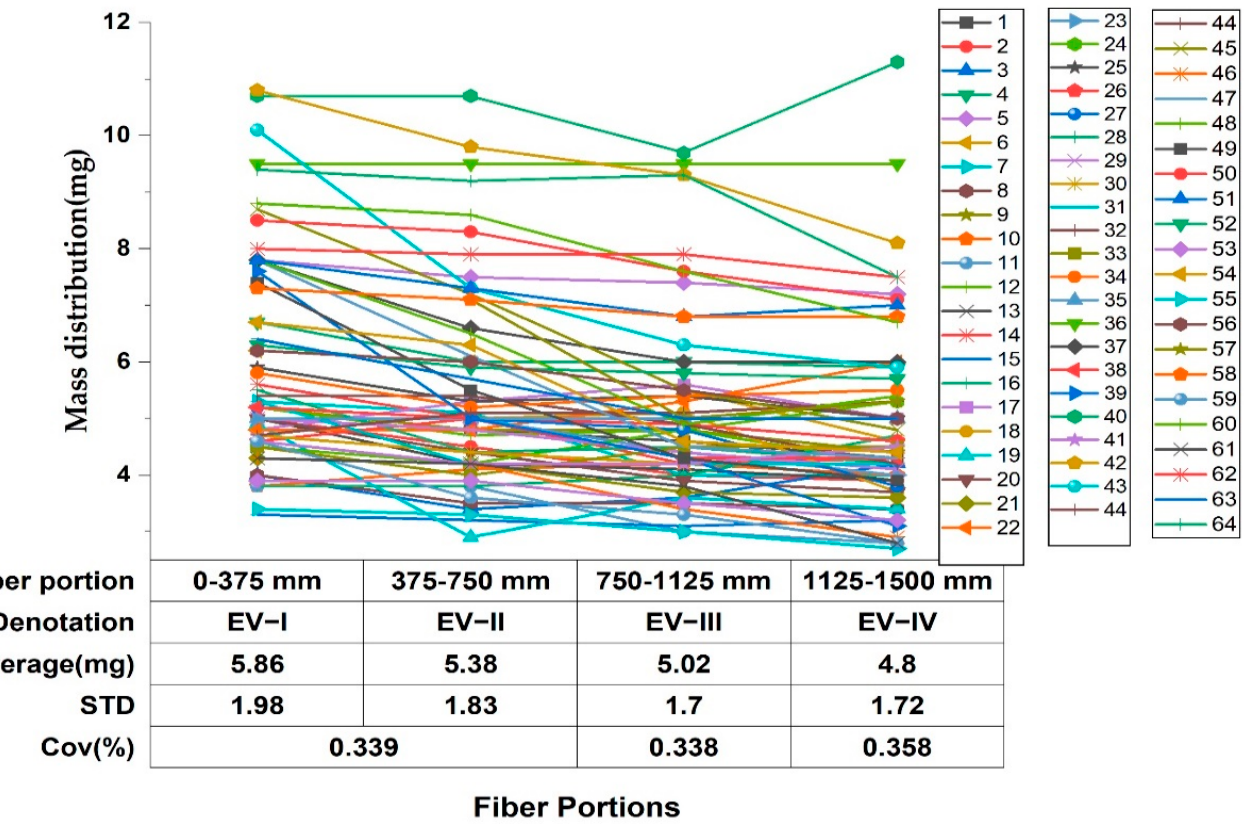
Figure 2. Enset bundle fiber portion along the length versus mass in grams. STD—standard deviation; CoV—coefficient of variation.